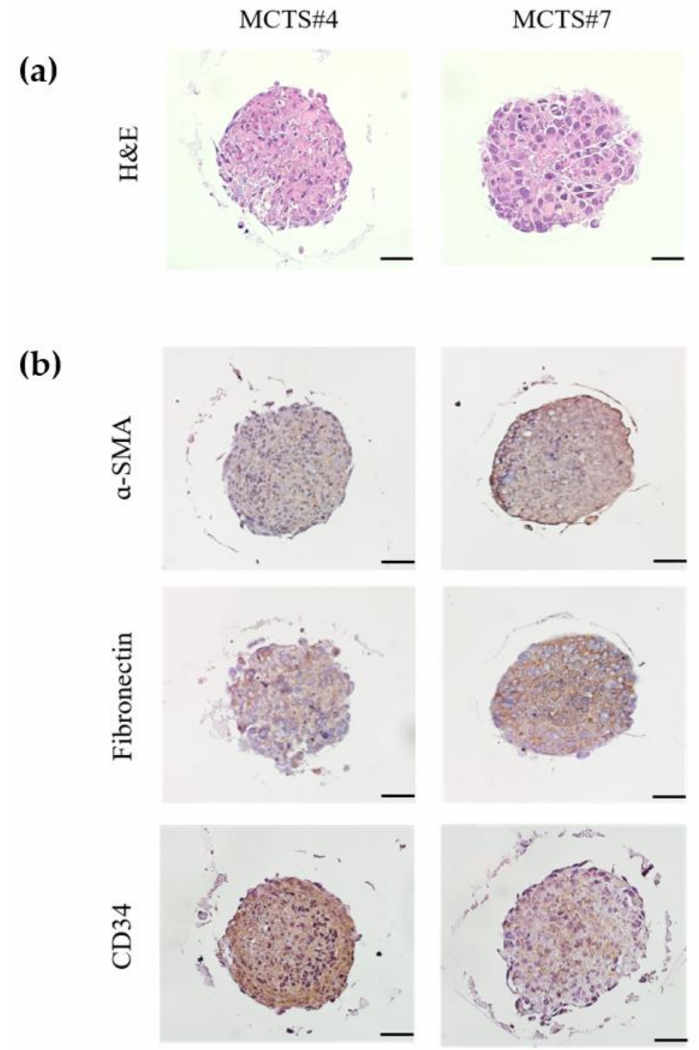
Figure 5. Establishment of MCTS model using patient-derived HCCs and stromal cells. ( a ) Hema- toxylin and eosin staining of MCTS; ( b ) Immunohistochemical analysis of α -SMA (marker for hepatic stellate cells, LX2), fibronectin (marker for fibroblasts, WI38), and CD34 (marker for endothelial cells, HUVEC) of consecutive sections of the MCTS model generated from patient-derived primary HCC cells cocultured with human stromal cells (LX2, WI38, and HUVEC). Representative images taken under a microscope ( × 200). Scale bar, 50 µ